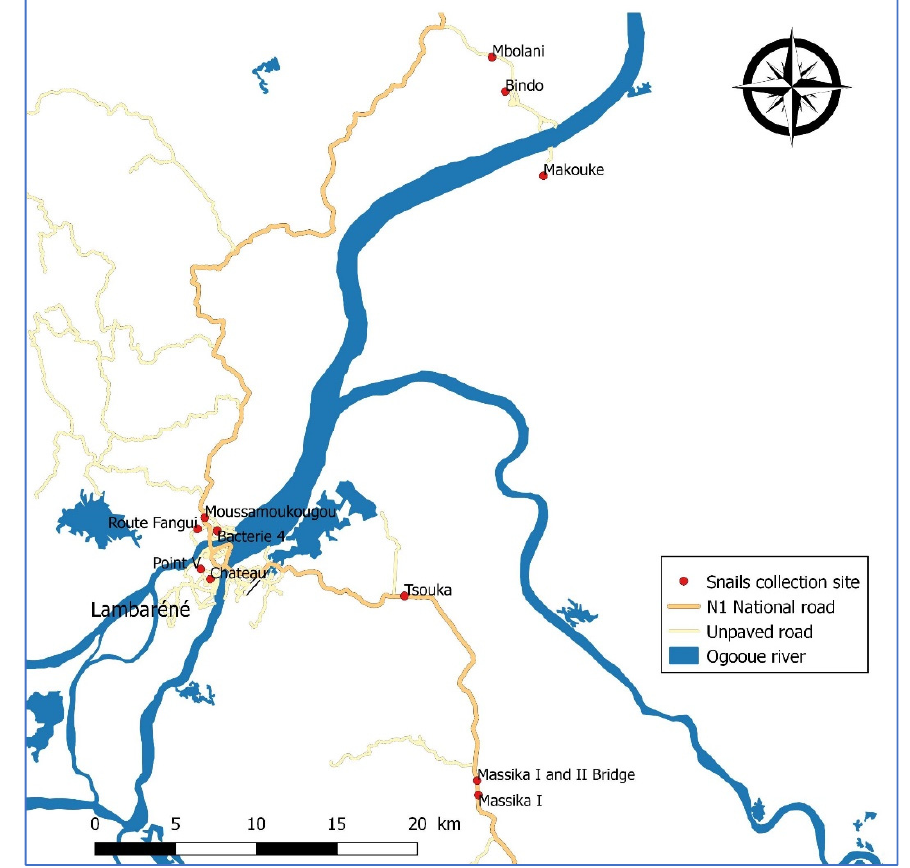
Figure 1. Distribution of the human-freshwater contact points selected for snail collection over the study area.